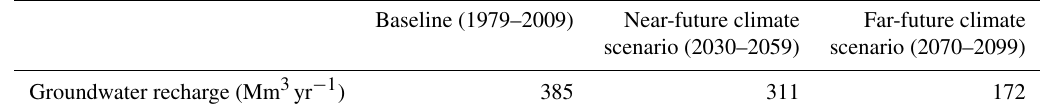
Table 7. Average annual groundwater recharge simulated on the entire basin scale in different periods. Baseline